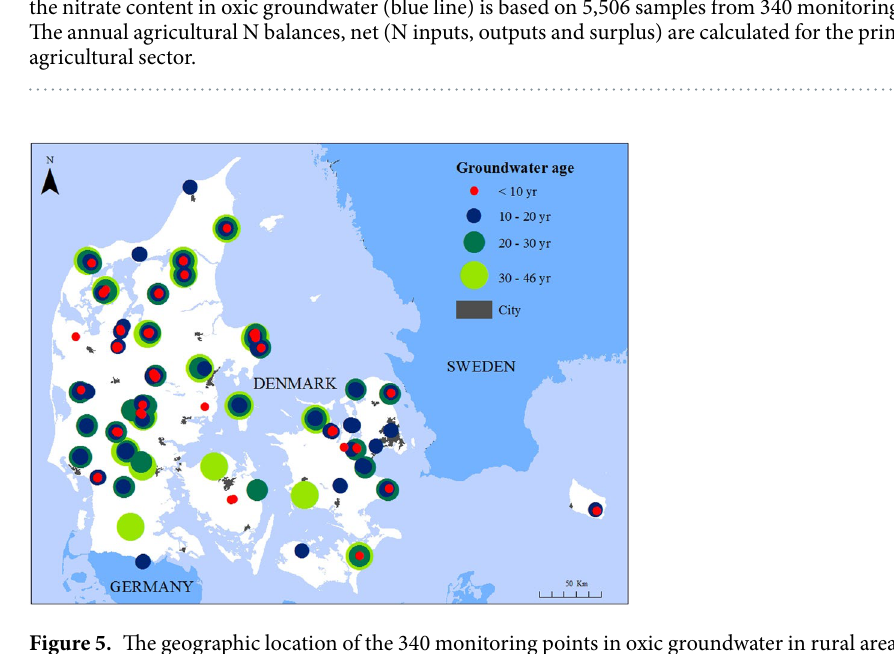
as also seen in other countries in the Western world 18, 27, 34 . Since the trend reversal, both the nitrate content in oxic groundwater and the N surplus have been declining. However, the amount of nitrate analyses per year in the highest class ( > 50 mg/l) has increased in the latest period (P4: 1998–2014). This might be due to a higher uncer- tainty because of lower data coverage in P4 compared to the former two periods (see Figs 2, 4 and 6). Danish agriculture has a high fertilization rate and livestock density compared with European and global averages 35 . N inputs to Danish agriculture increased from 1946 until 1990 from about 46 to 240 kg N ha − 1 yr − 1 . By 2012, the N inputs had declined to around 170 kg N ha − 1 yr − 1 . Different factors might have influenced the decrease in N input, as changes in land use. However, it is most likely that it is due to a drop in the use of synthetic fertilizer due to a better N use efficiency stimulated by the different N mitigation measures in the environmental action plans (Table 1). These N mitigation measures include better management and utilization of N in animal manure, statutory norms for fertilizer N application for specific crops, maximum limits on N applied to specific crops under economical optimum levels, and increasing use of catch crops. In line with the increasing N inputs, the N outputs also increased from 1946 to 1990, from about 18 to almost 80 kg N ha − 1 yr − 1 due to increased agricultural production. The increased agricultural production since the 1940s,